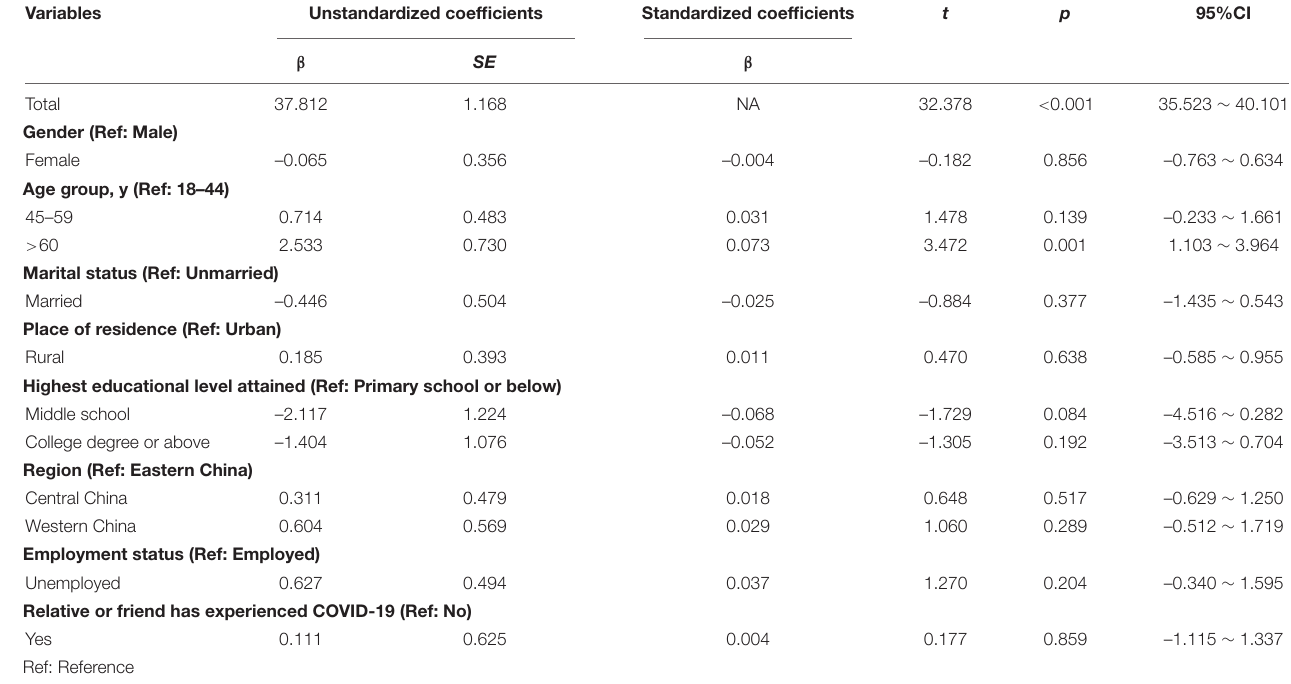
TABLE 2 | Regression analysis of associated factors for CES-D Scores among